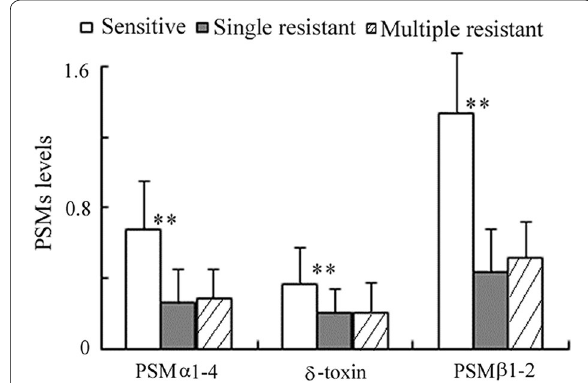
Fig. 3 PSMs expression in sensitive and drug-resistant foodborne S. aureus . The PSMs in single and multiple antibiotic resistant strains were significantly lower than those in sensitive strains, respectively. Results were expressed as the ratio of PSMs levels in tested strains to those in USA300. ** p < 0.01